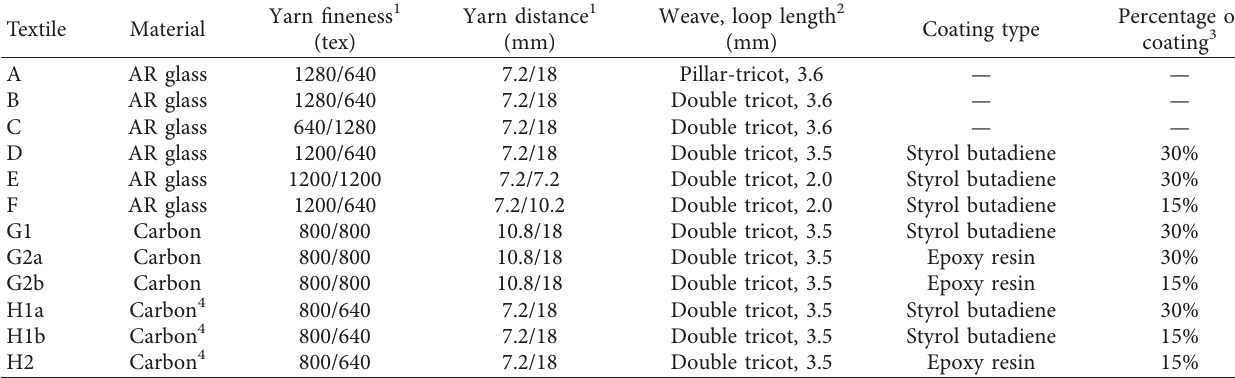
Table 1: Parameter specification of 1st batch of